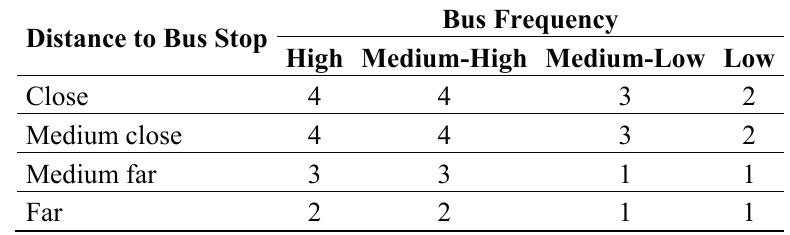
Table 1. Categorization of the bus convenience based on bus frequency and distance to a bus stop with 4 indicating the highest bus